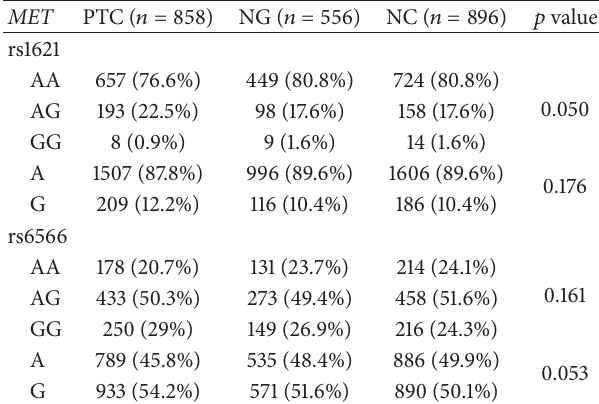
Table 1: Allele and genotype frequency of MET SNPs in patients with PTC and NG and